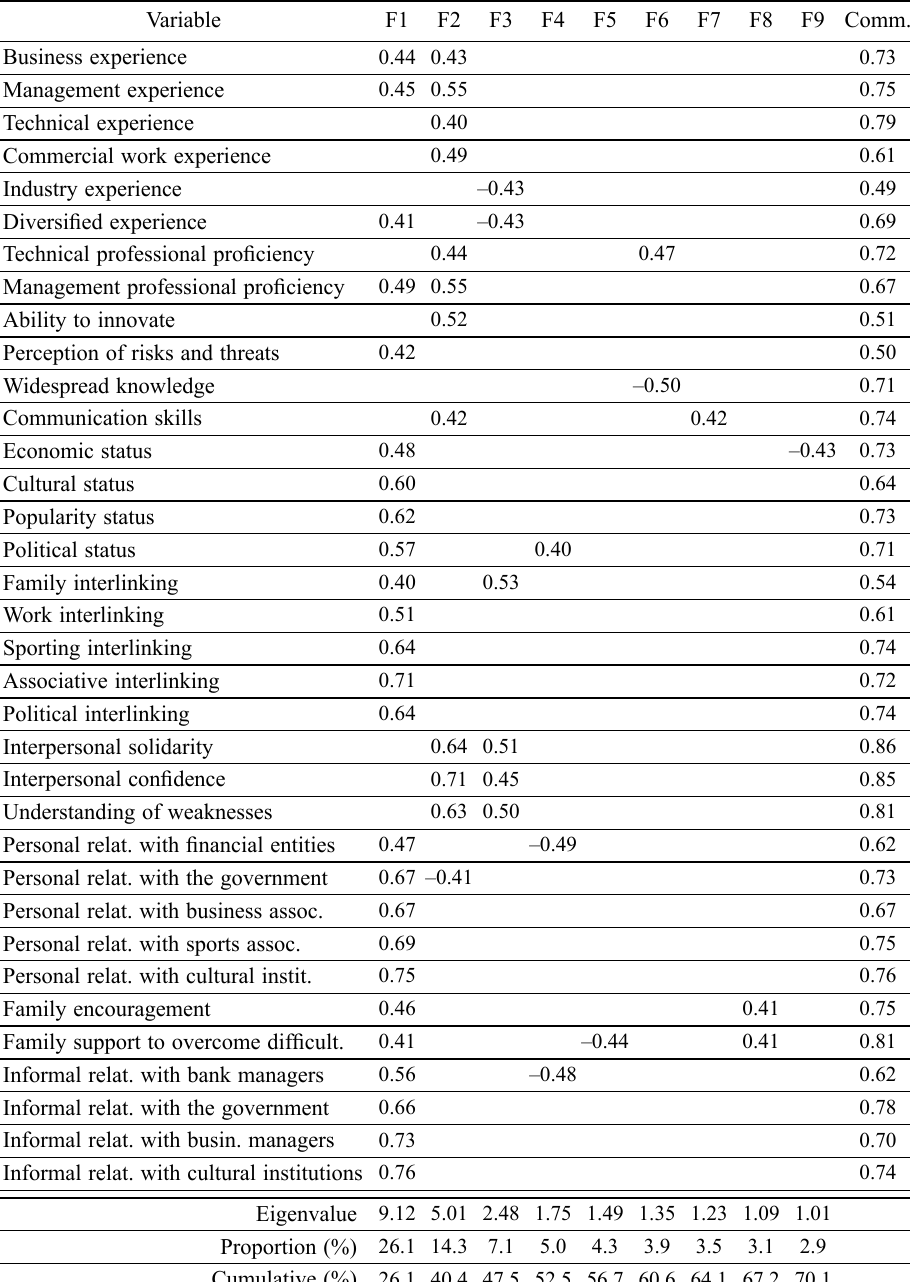
Table 3. Factor analysis for human and social capital